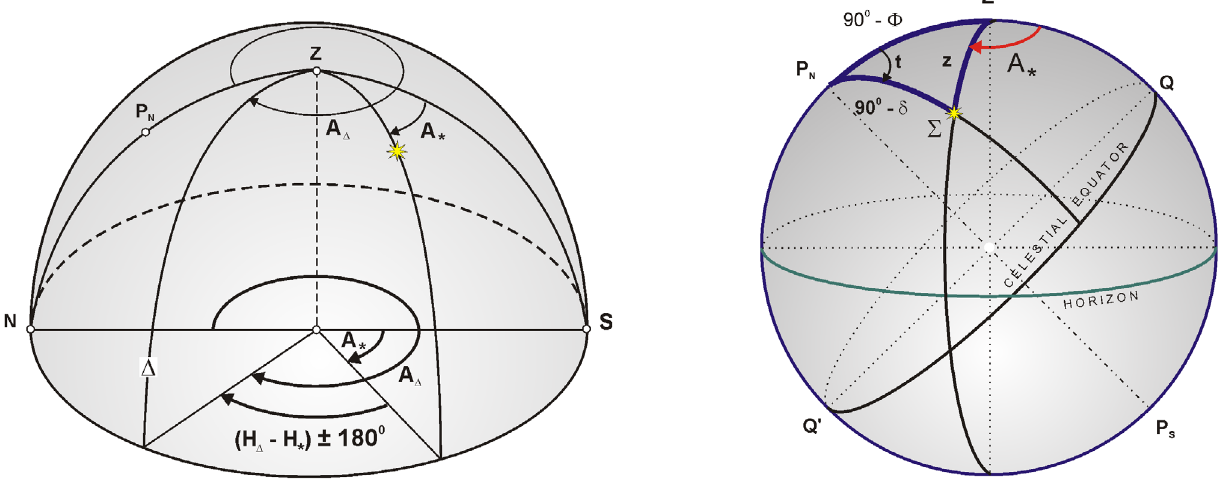
Figure 4. Relationship between the astronomic azimuth of the celestial body and the reference mark (left). Astronomic azimuth on the celestial sphere